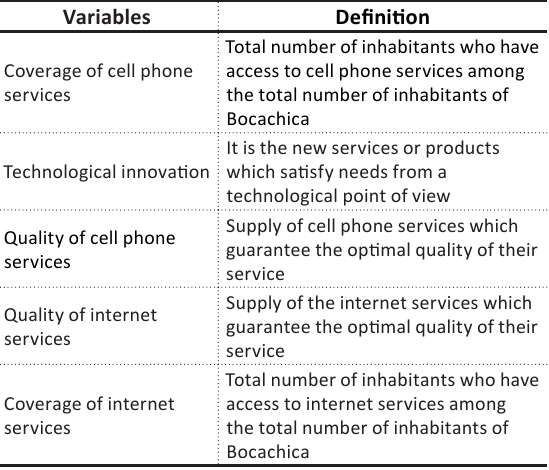
Source: Elaborated by the authors.